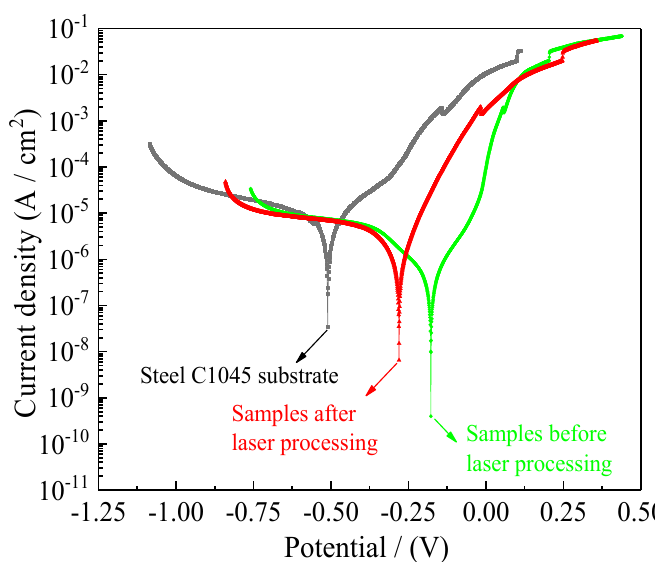
Figure 23. Potentiodynamic polarization curves of samples before and after laser processing. Table 6. Analyzing results of potentiodynamic polarization curves of samples.